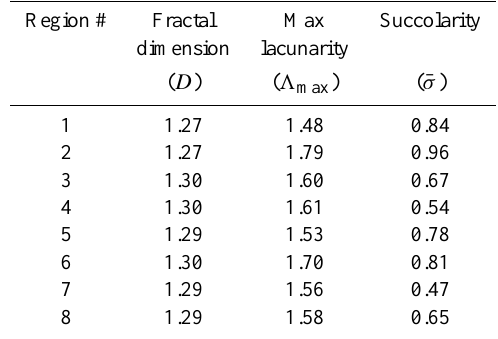
Table 1. Summary of the nonlinear measures i.e. fractal dimension, lacunarity and succolarity analyses of eight selected